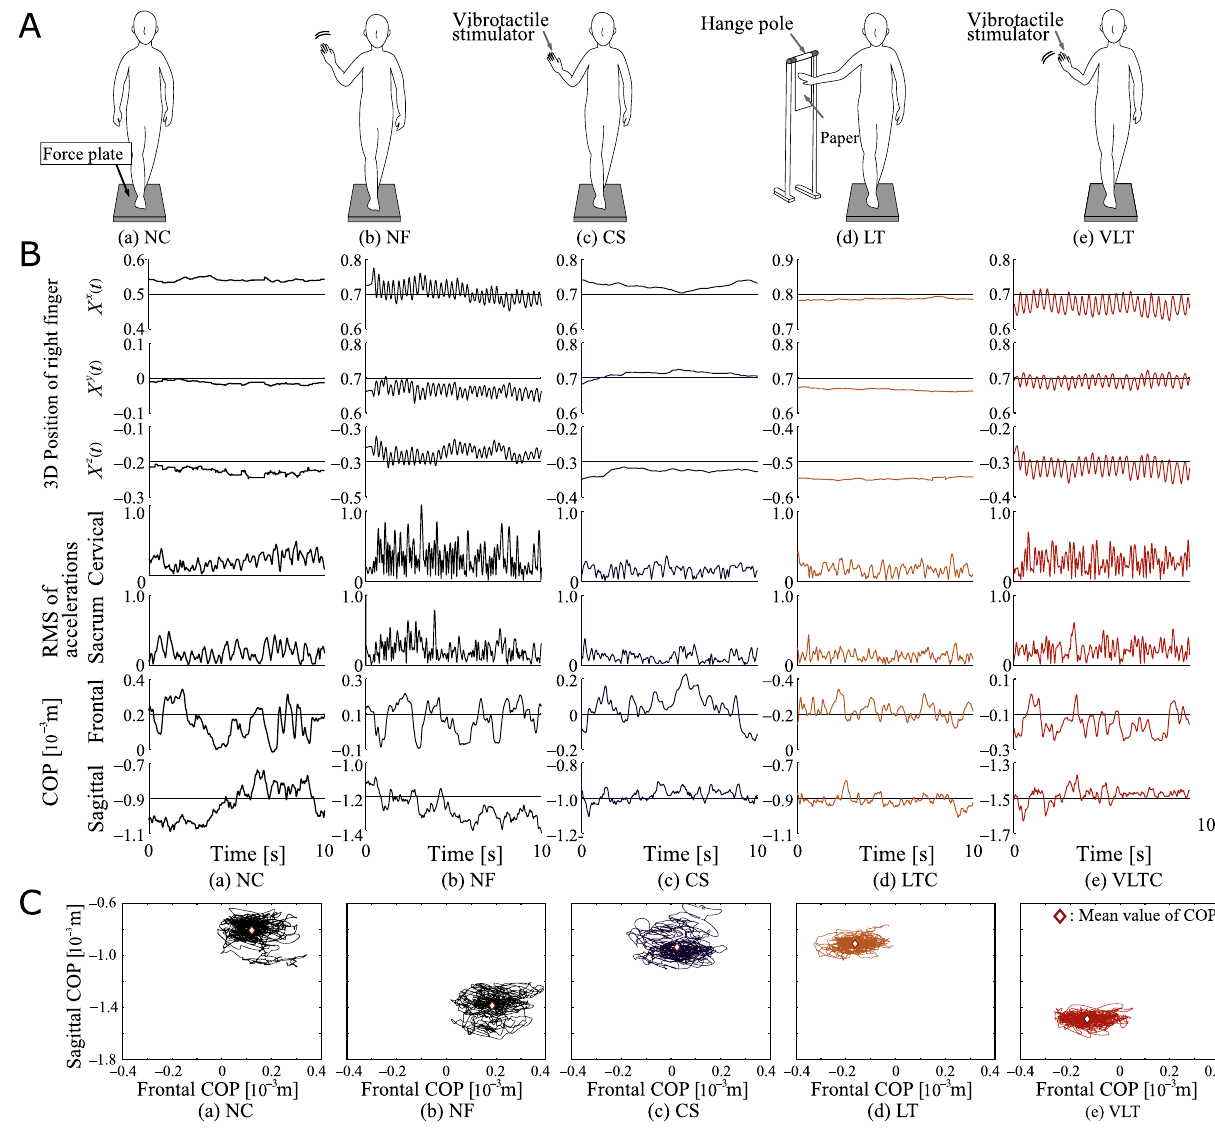
Figure 4. Tasks and results from experiments 1 and 2. The figures show (a) the subject’s posture with no contact (NC) anywhere, (b) NC with the hand moving to touch the virtual partition without feedback (NF), (c) NC with constant stimulation applied to the fingertips (CS), (d) light touch with a piece of paper hanging to the subject’s right (LT), and (e) virtual light touch with the right hand (proposed method; VLT). ( A ) Tasks for each condition ( B ) Experimental results; from top to bottom: 3D fingertip position; acceleration RMS; ( C ) COP trajectories for each